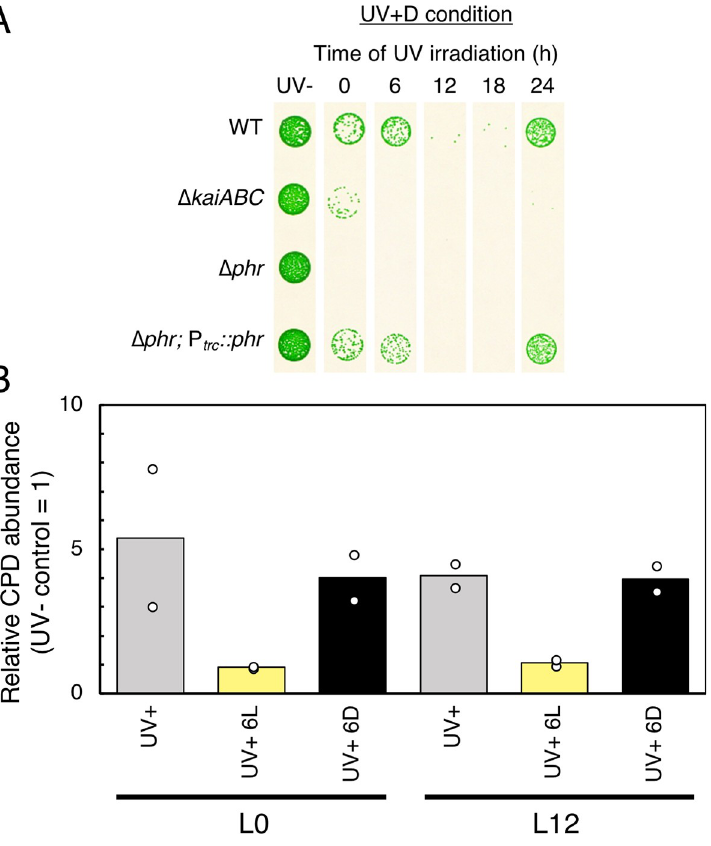
Fig 3. Importance of DNA photorepair activity and its circadian independency. (A) Growth of UV-C-irradiated cells of each mutant strain under the UV+D condition. Δ phr , phr -deficient strain. In the Δ phr; P trc :: phr strain, phr was :: phr strain, ectopic phr expression expressed under the trc promoter with a phr -deficient background. In the Δ phr ; P trc at the leaky level without IPTG was sufficient to recover the circadian rhythm of UV-C resistance. Representative data of three independent experiments are shown. (B) Genomic DNA damage, as quantified by ELISA using a CPD-specific antibody. Genomic DNA was extracted from cells after UV irradiation at hour 0 or 12 in the light. The cells were harvested immediately after UV irradiation, (control sample: UV+) and exposed to the light for 6 h (light repairing sample: UV+6L) or the dark for 6 h (inhibiting repair sample: UV+6D). The vertical axis shows signal value obtained by CPD ELISA. In each case, the CPD level was normalized to samples without UV irradiation, which were assigned signal values of 1 ( n = 2). Each plot indicates the result of two independent experiments, and bars indicate the mean